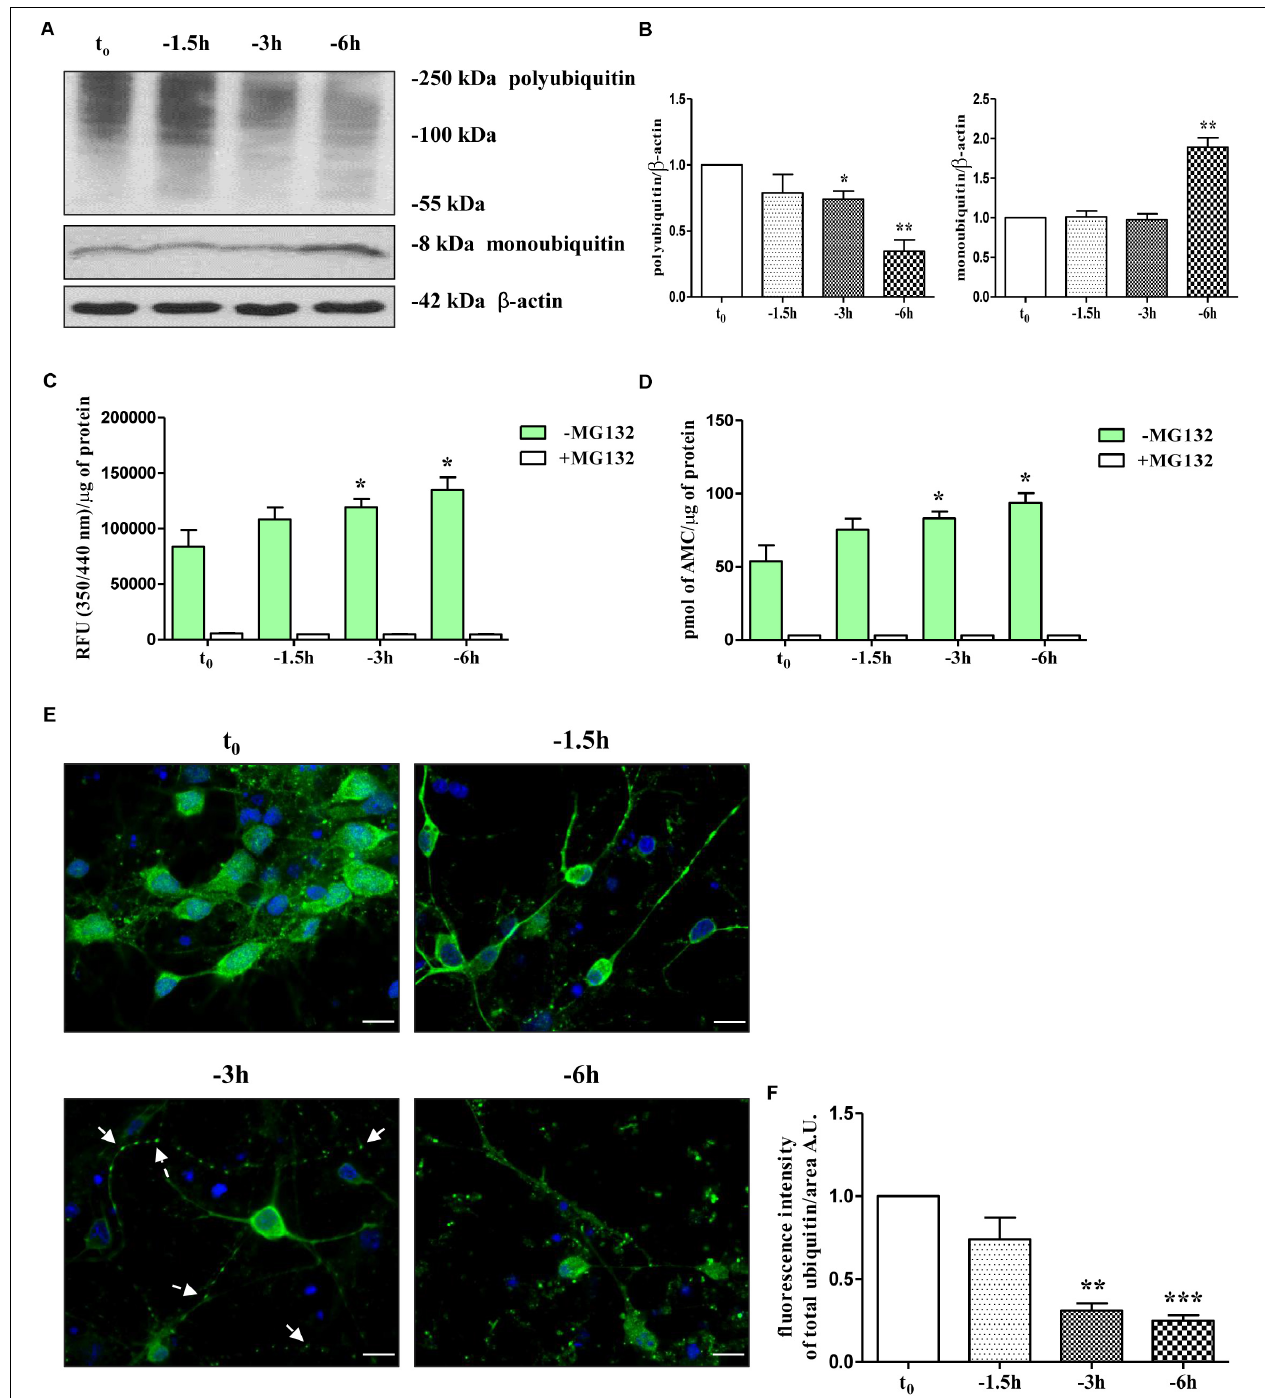
FIGURE 1 | UPS activity is early stimulated by NGF starvation in septo-hippocampal primary neurons. (A,B) Western blotting analysis was carried out on equal amounts of total protein extract (20 µ g) from septal primary neurons cultured for 10–12 D.I.V. in defined medium supplemented with 0.2% B27, in the presence ( t 0 ) or absence (–1.5, –3, –6 h) of exogenously added NGF (100 ng/ml). By probing with anti-pan ubiquitin antibody (Dako antibody Z0458), immunoblots showed the reduction of polyubiquitinated protein conjugates and, inversely, a parallel increase in the free monoubiquitin which are indicative of an accelerated UPS degradative function(s). Molecular weights are indicated on the right of the blots and expressed in kDa. Densitometric quantification of immunoreactivity levels was normalized by calculating the ratio of the intensity of HMW-smeared signal and monoubiquitin to that of β -actin which was used as loading control for each sample/lane. Values are mean ± standard error of the mean (SEM) of at least five independent experiments and are expressed with respect to control neurons ( t 0 ) at the respective